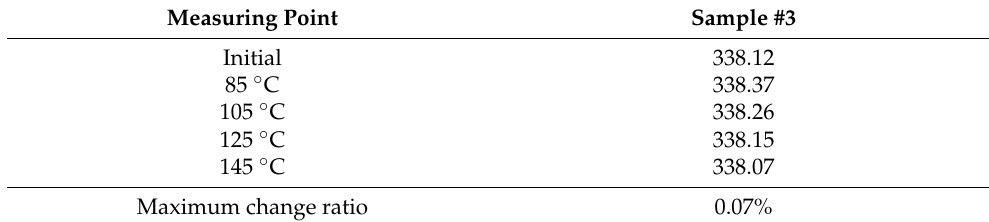
Table 4. The scale factor of the samples (unit: mV/g).